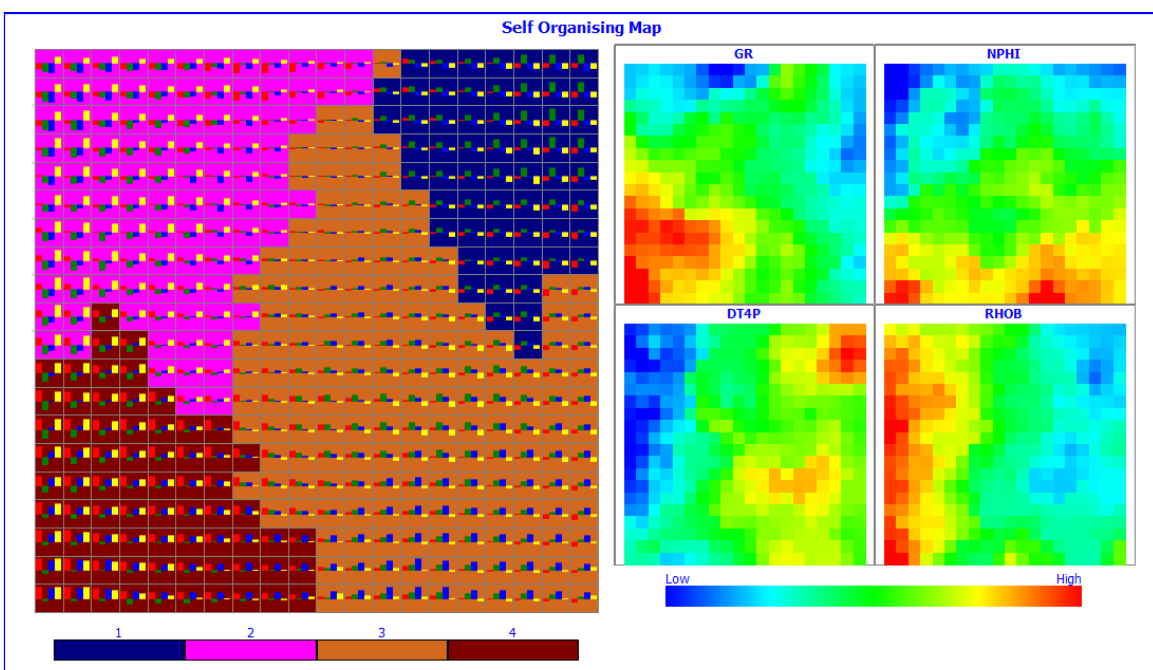
Figure 5. Component SOM model planes for the four input parameters after calibration.